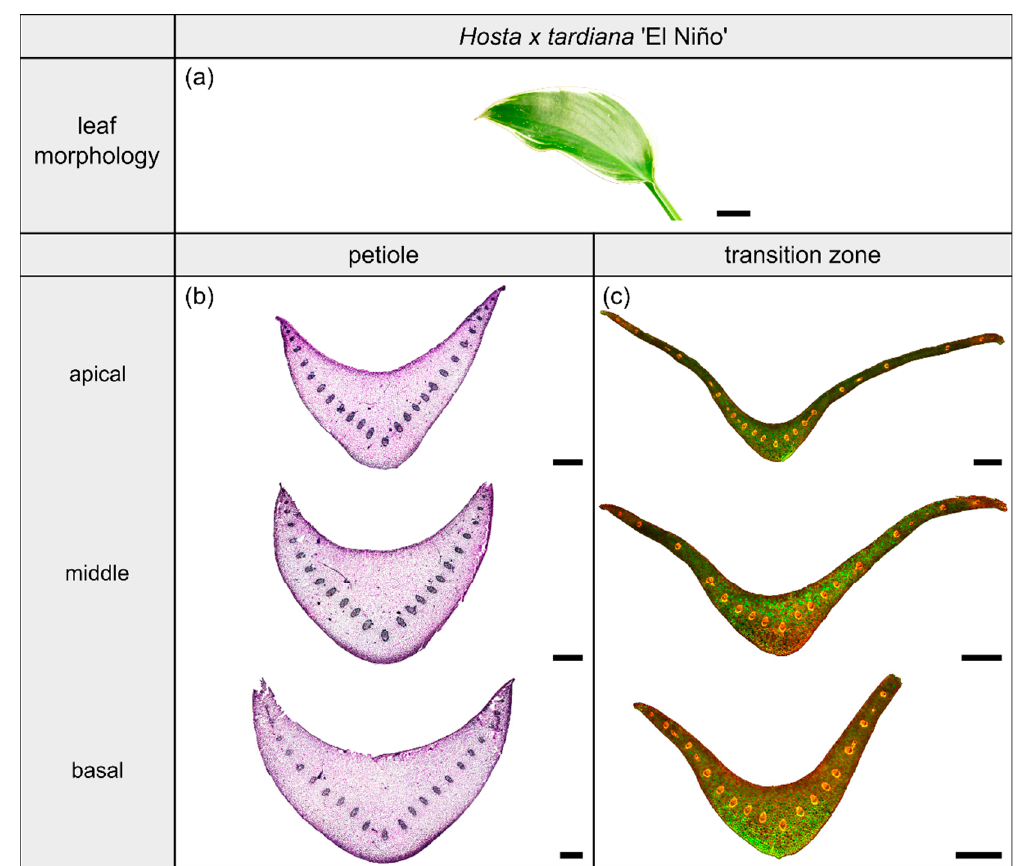
Figure 3. Morphology and anatomy of the foliage leaf of Hosta x tardiana ‘El Niño’ ( a ). The thin-sections of the transition zone are stained with acridine orange ( c ), while the thin-sections of the petiole are stained with toluidine blue ( b ). The scale bar of the leaf morphology equals 2 cm and those of the anatomical sections equal 1 mm.